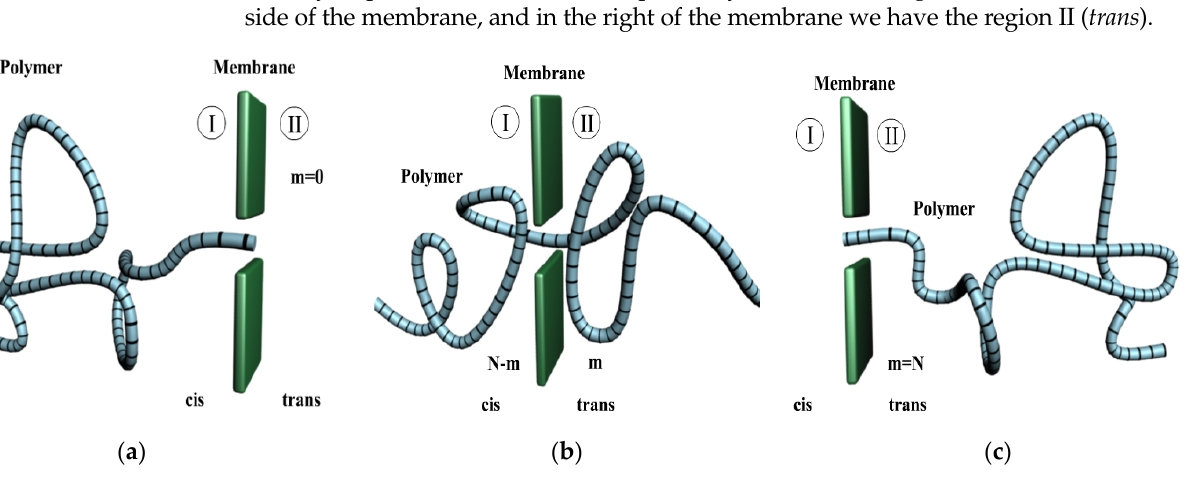
Figure 1. Polymer in transition through nanometer pore: ( a ) The charged polymer is found in the cis zone (region I), ( b ) The polymer has m monomers in the trans area and N-m monomers in the cis area, ( c ) The charged polymer is entirely found in the trans zone (region II).